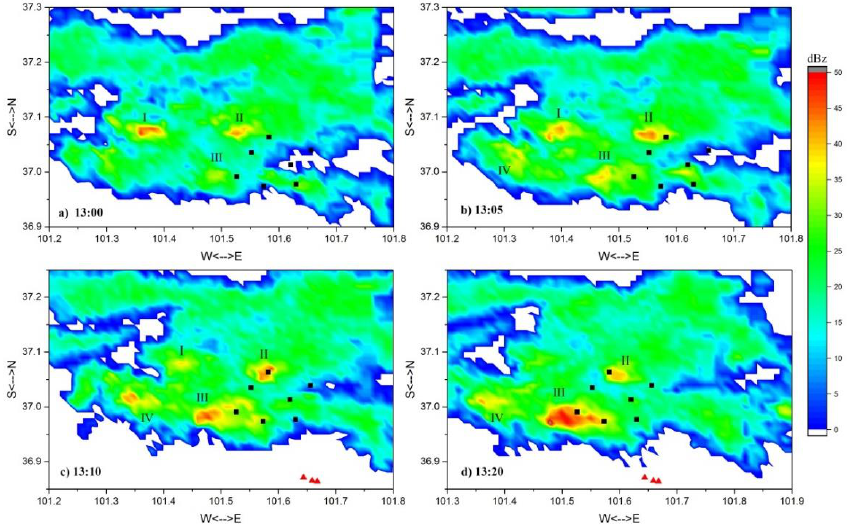
Figure 2. Evolution of the storm cells at the beginning of the thunderstorm process: ■ represents observation sites, ▲ represents the three villages of hail disaster, and I – IV represent the serial numbers of thunderstorm cell.